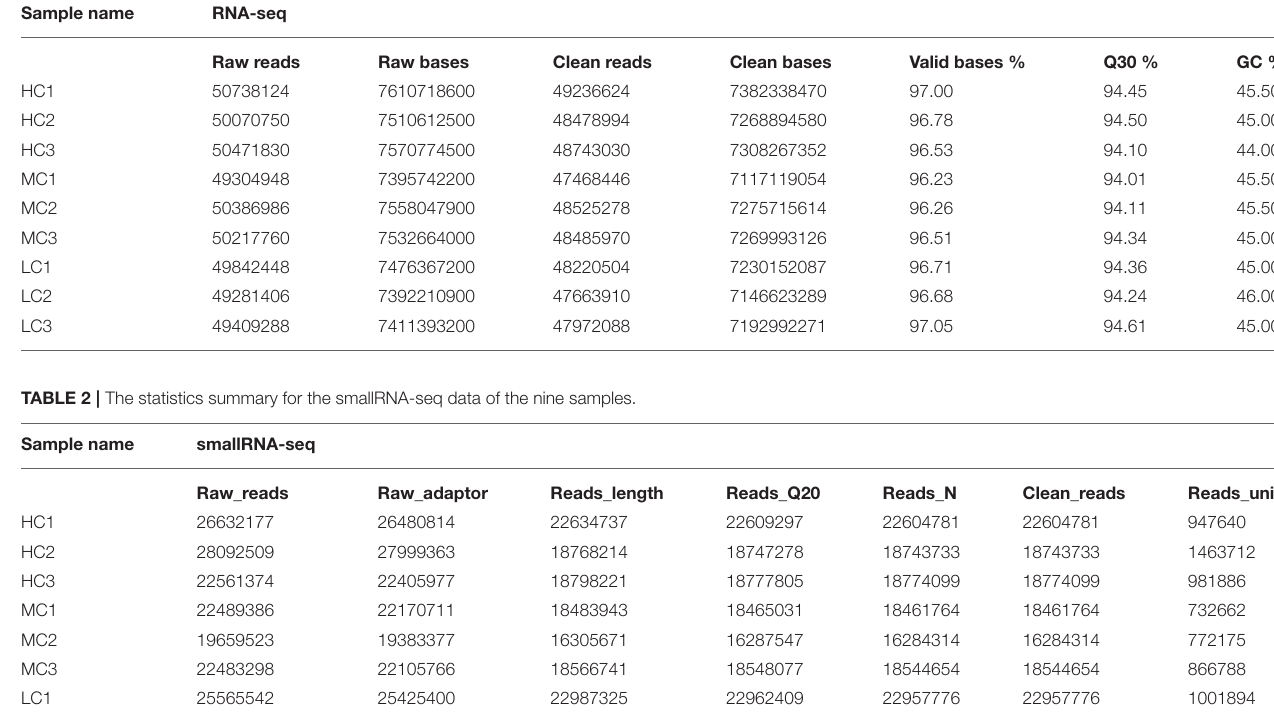
TABLE 1 | The statistics summary for the RNA-seq data of the nine samples.